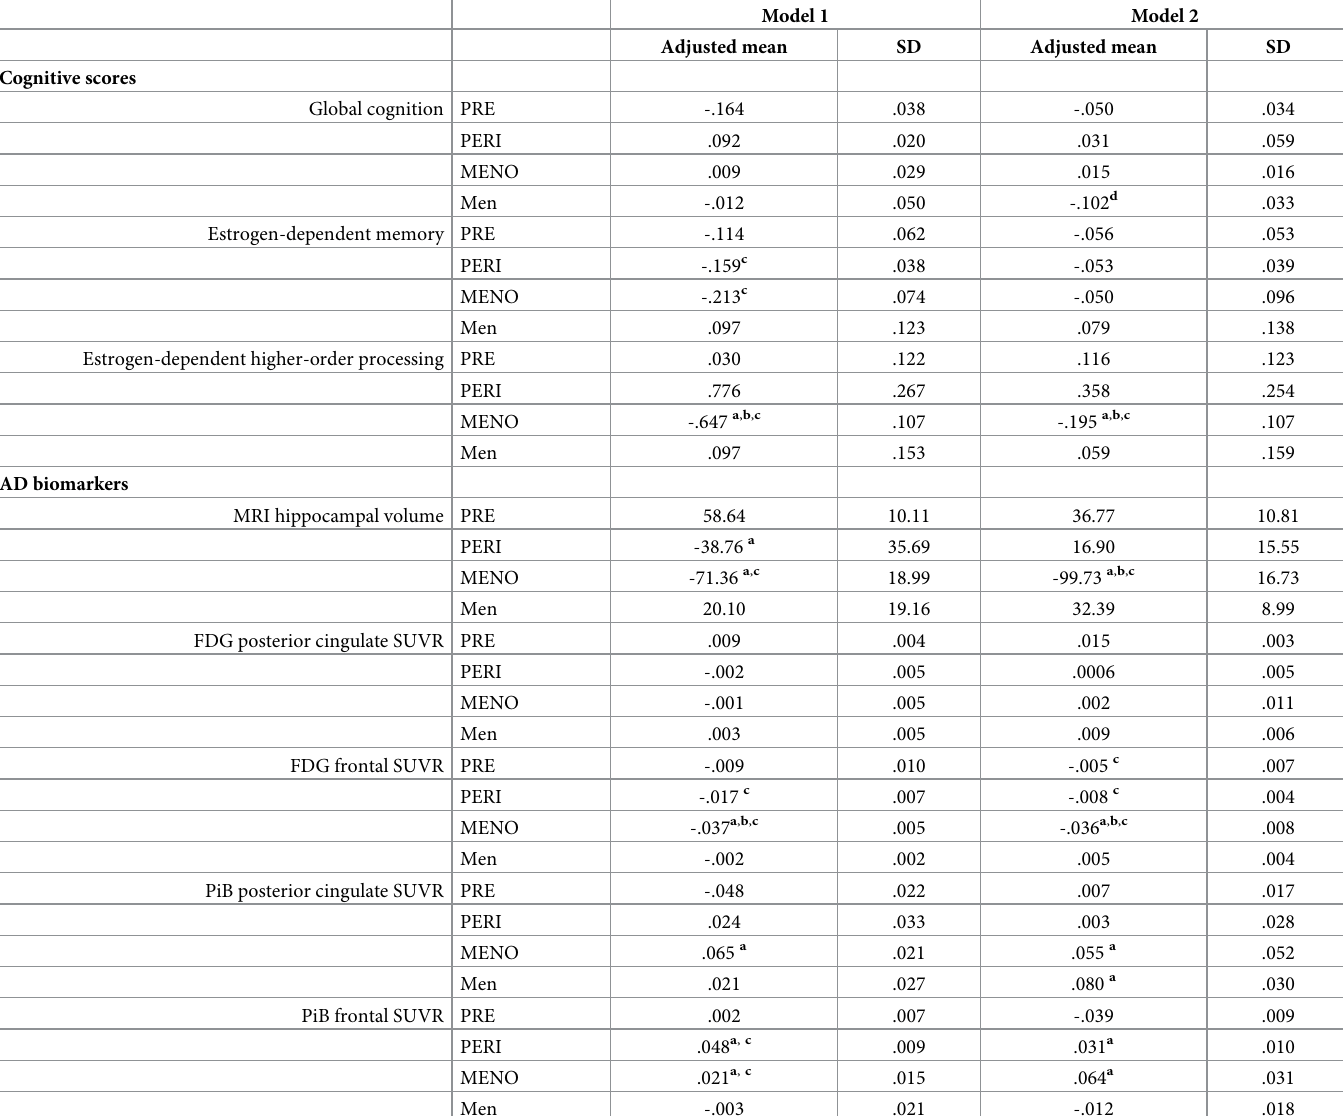
Table 2. Adjusted means of cognitive and biomarker change by